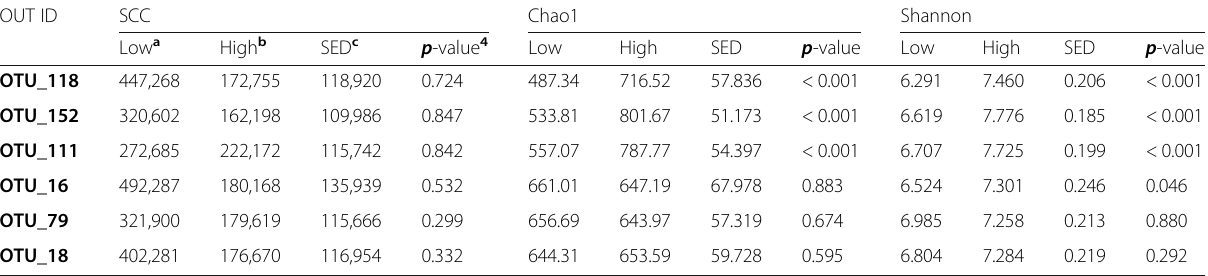
Table 1 Summary statistics comparing biodiversity and somatic cell count (SCC) of milk samples categorized based on high ( ≥ 10/ 4000 OTUs/sample) and low abundances of hub OTUs OUT ID